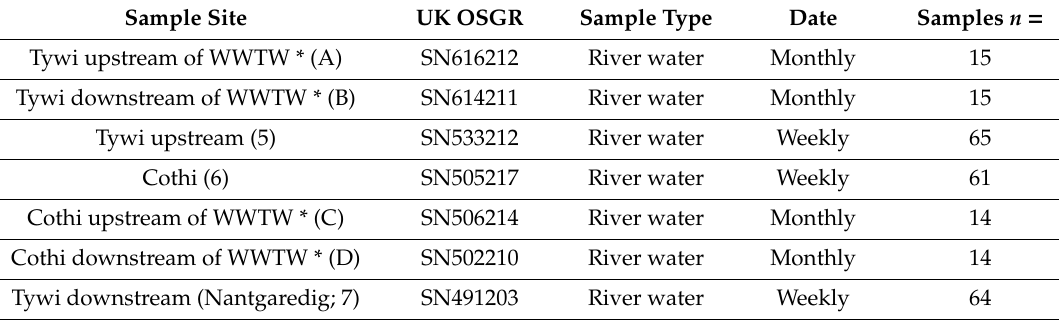
Table 1. Sampling sites for weekly / monthly samples (2010–2011). Sample